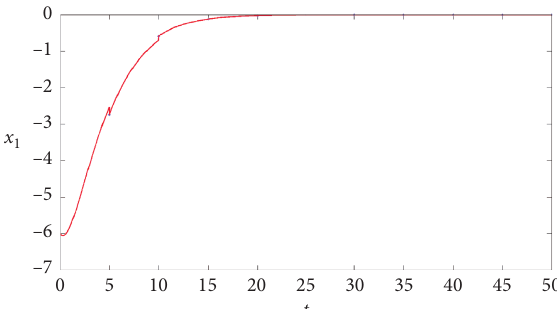
of system (31) corre- 1